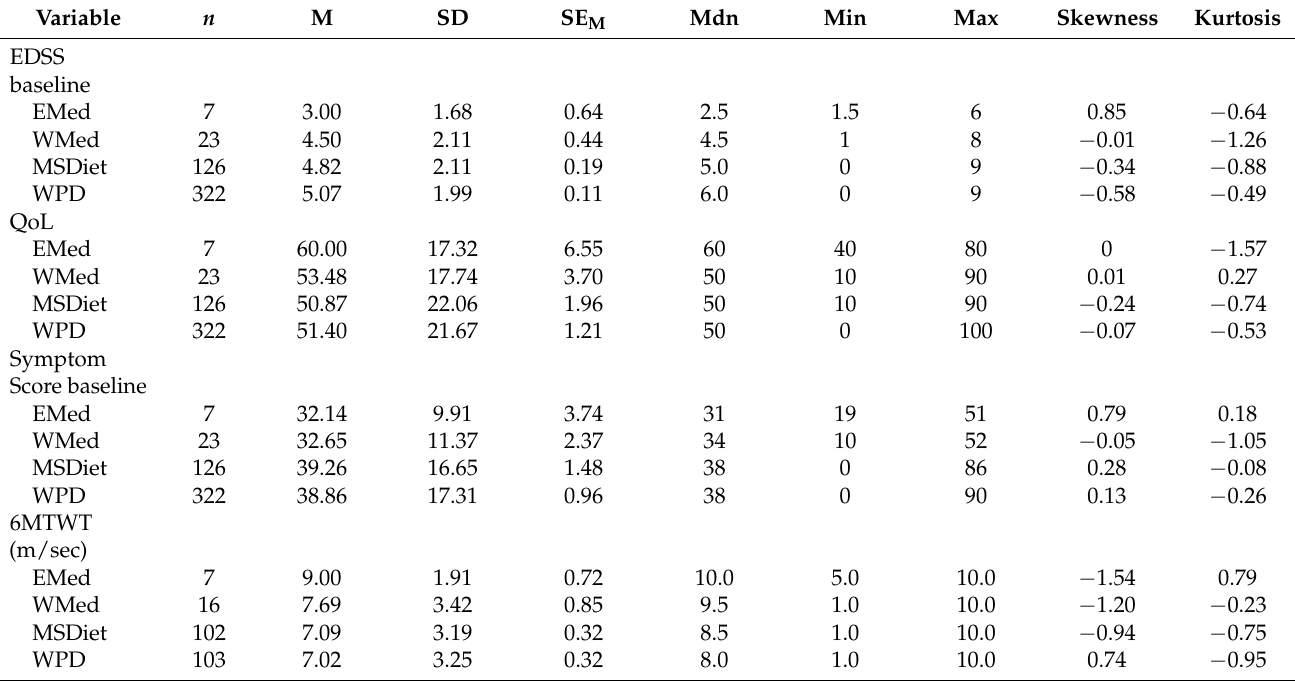
Table 4. Summary statistics table for EDSS, QoL, Symptom Score, and 6MTWT by diet group.